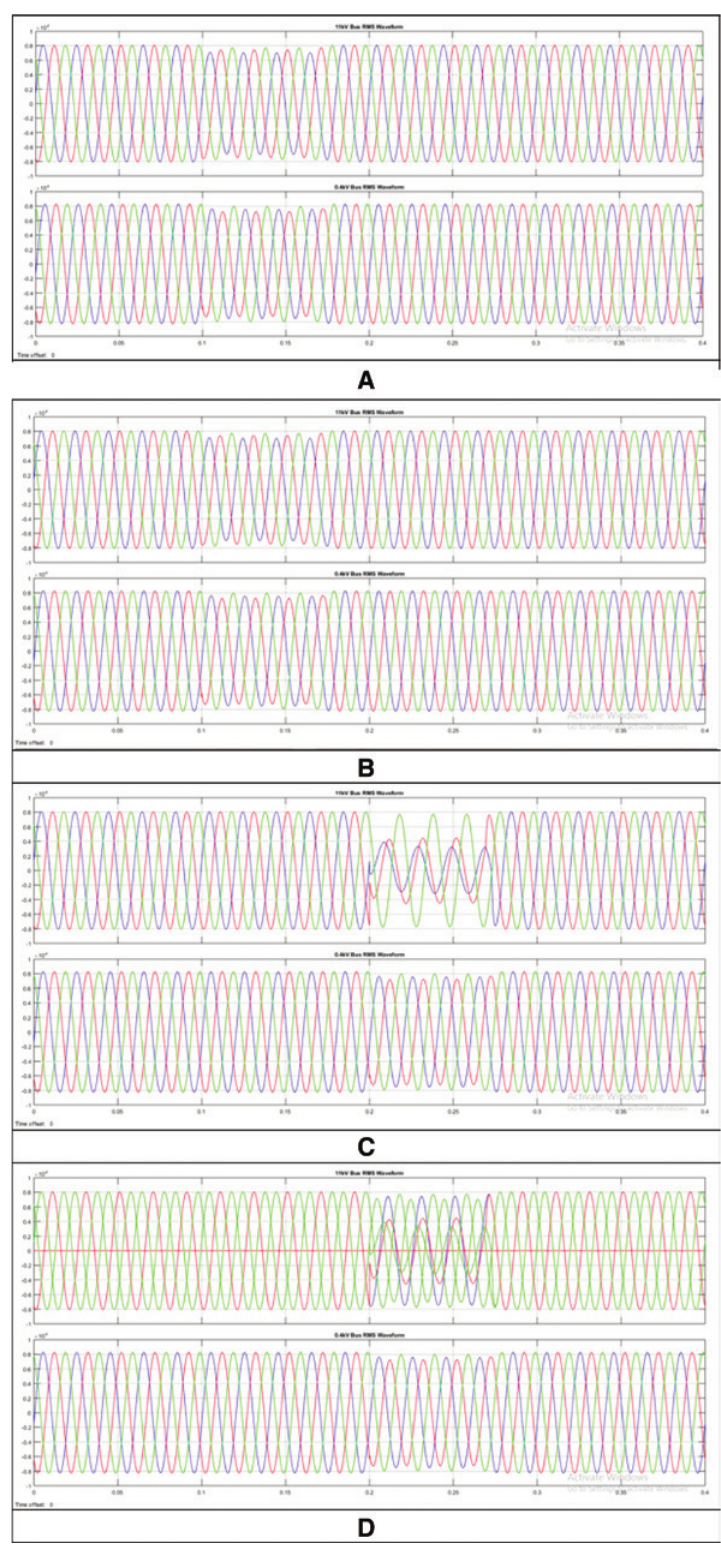
Figure 3: Behavior of Signals in Various Transmission Lines. Behavior of Signals in (A) Transmission Line 1, (B) Transmission Line 2, (C) Transmission Line 3, and (D) Combined Signal